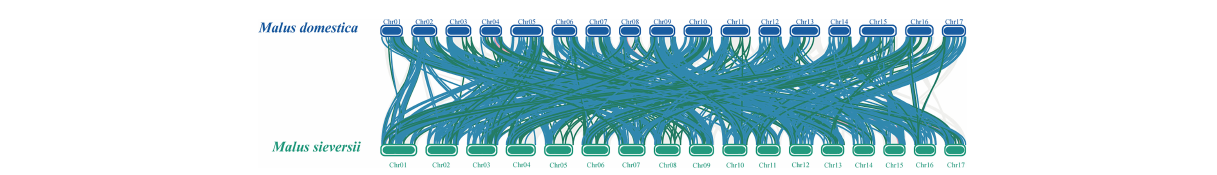
FIGURE 4 Collinearity analysis of MYB genes between Malus domestica and Malus sieversii . Syntenic regions between Malus domestica and Malus sieversii chromosomes are connected by different color lines. Gray lines and colored lines represent the collinear blocks and syntenic MYB gene pairs, respectively, including 1R-MYB (blue), R2R3-MYB (green), and 3R-MYB (pink).